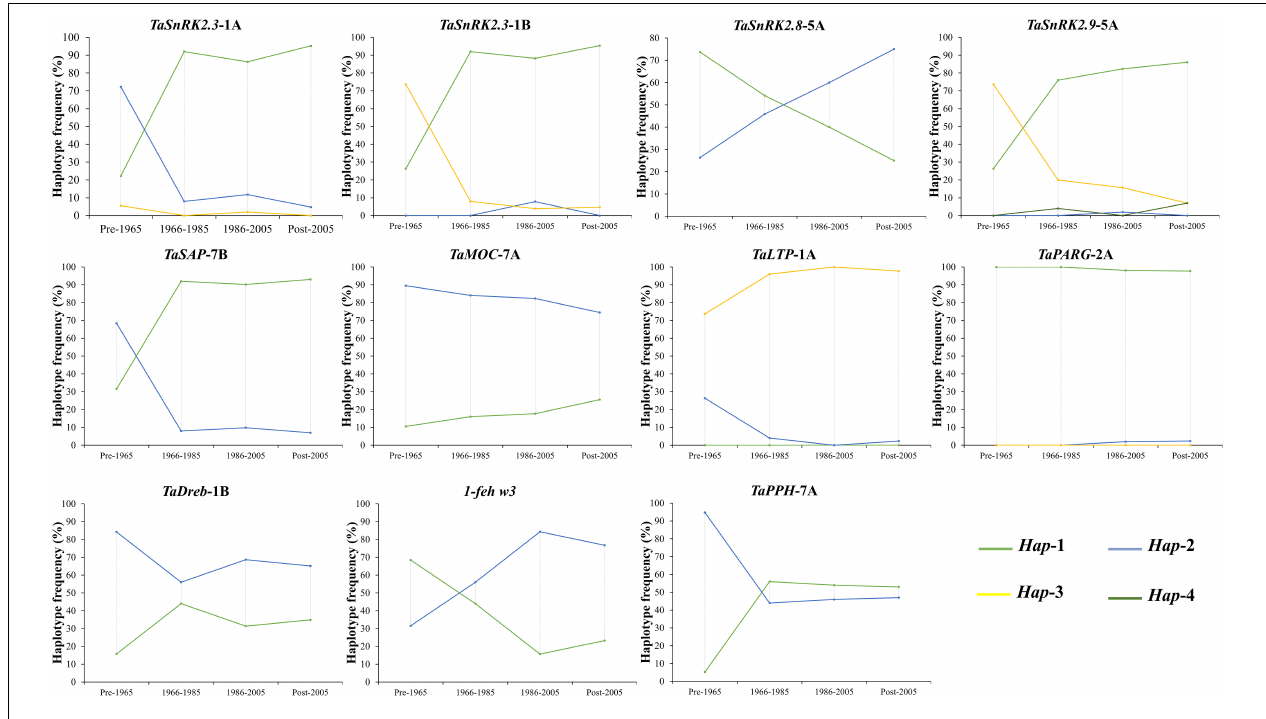
FIGURE 3 | The frequency of drought-tolerant genes’ haplotypes in Pakistani wheat cultivars released in different eras. TABLE 2 | Polymorphic information contents and gene diversity in diploid, tetraploid, and hexaploid Pakistani wheat. Genes Diploid wheat Tetraploid wheat Hexaploid wheat Alleles/Haplotypes PIC H e Alleles/Haplotypes PIC H e Alleles/Haplotypes PIC H